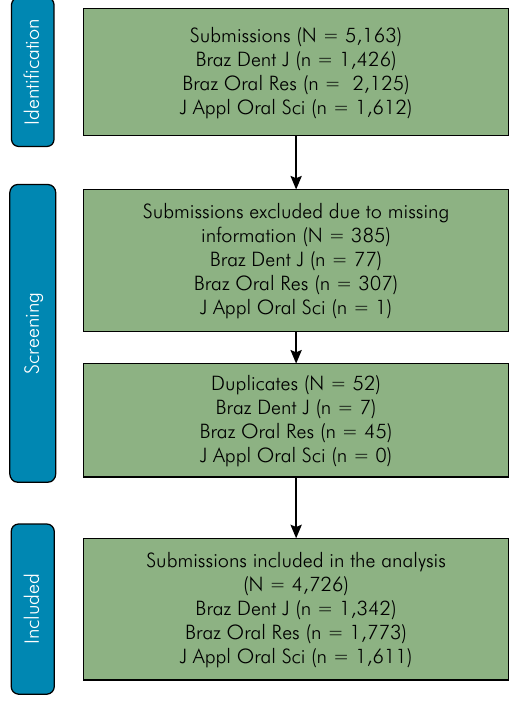
Figure 2. Flow diagram of article submissions included in the